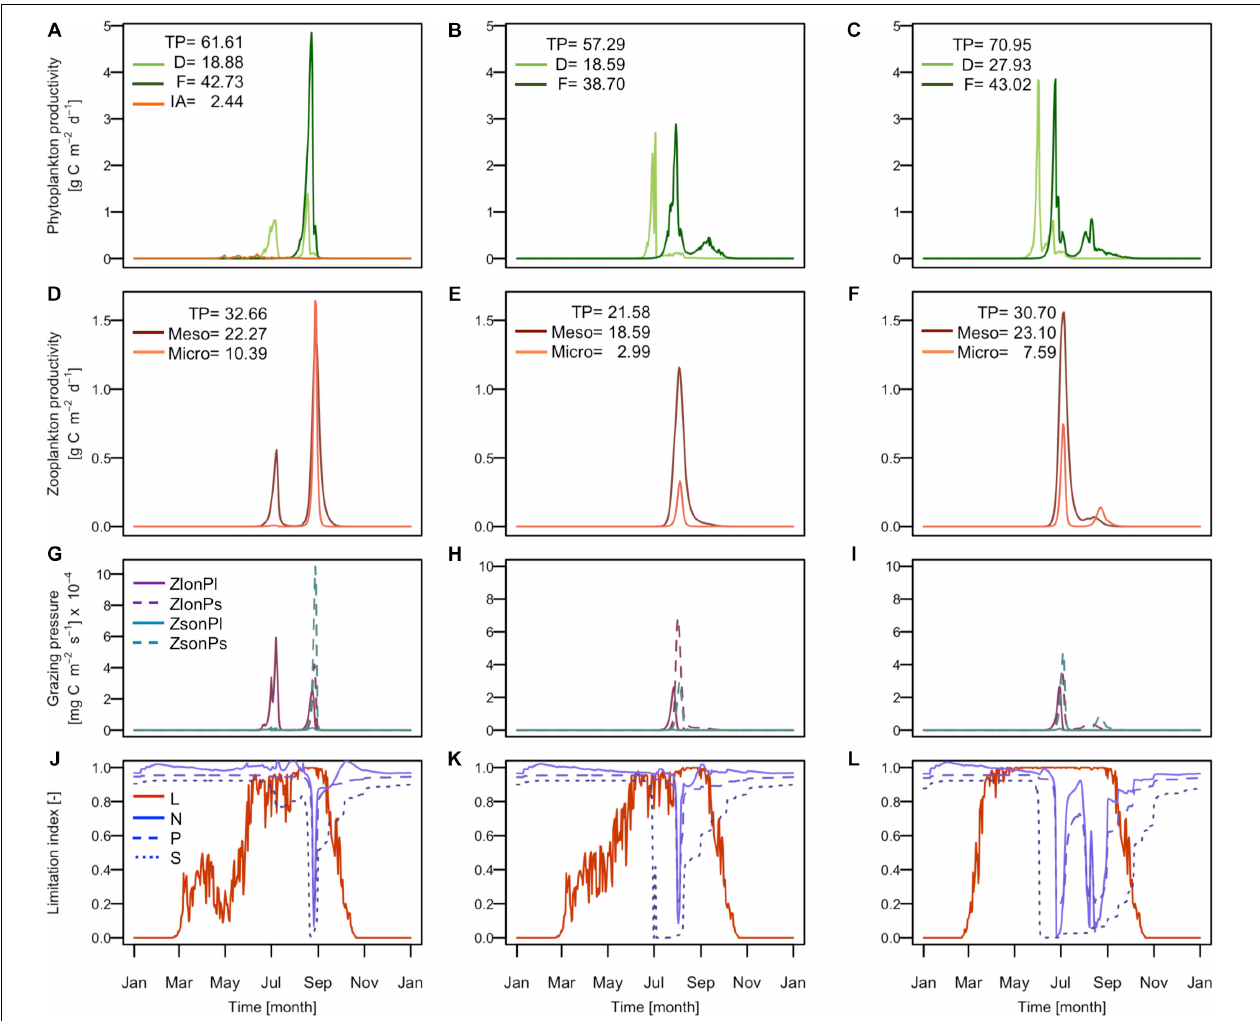
FIGURE 4 | Simulated sympagic and pelagic primary and secondary production, predation pressure of zooplankton on phytoplankton and nutrient and light growth limitation in the surface layer (4 m depth) for full coupling experiment (A,D,G,J) , physical coupling experiment (B,E,H,K) , and free ice experiment (C,F,I,L) . Time series of (A–C) primary production rates of ice algae (IA: orange), diatoms (D: light green), and flagellates (F: dark green), (D–F) secondary production rates of mesozooplankton (Meso: dark red) and microzooplankton (Micro: orange), (G–I) grazing rates of large and small zooplankton on large and small phytoplankton, and (J–L) growth limitation index for light (solid orange), nitrogen (solid blue), phosphate (dashed blue), and silicate (dotted blue). In the legend (A–F) are indicated the annual production in gC m 2 for total pelagic production (TP), diatoms (D), flagellates (F), ice algae (IA), mesozooplankton (Meso), and microzooplankton (Micro). In the legend (G–I) are indicated large zooplankton grazing rate on large phytoplankton (ZlonPl), large zooplankton grazing rate on small phytoplankton (ZlonPs), small zooplankton grazing rate on large phytoplankton (ZsonPl), and small zooplankton grazing rate on small phytoplankton (ZsonPs). In the legend (J–L) are indicated light limitation (L), nitrogen limitation (N), phosphate limitation (P), and silicate limitation (S) at the surface